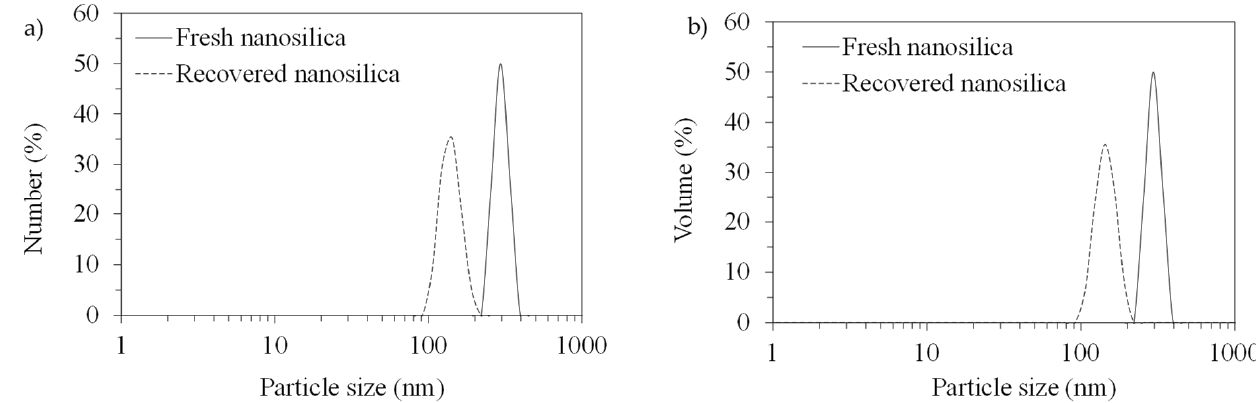
Figure 8. DLS analysis of fresh ( a ) and recovered nanosilica ( b ).